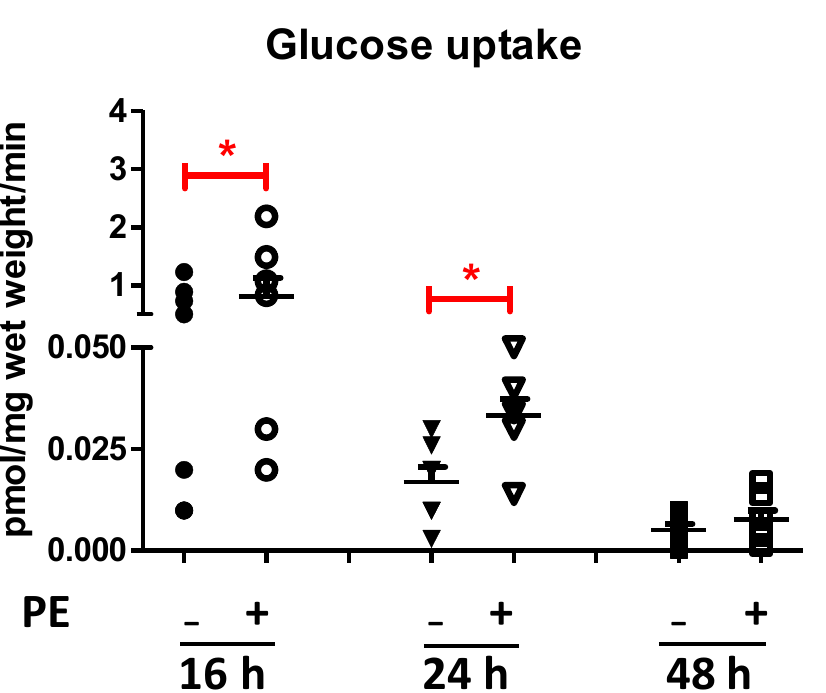
Figure 3. Time-dependent effect of phenylephrine on cellular substrate uptake. Glucose uptake after 16 h, 24 h, and 48 h phenylephrine (50 µM) stimulation, expressed in pmol/mg wet weight/min. Values are expressed as means ± STDEV for each incubation time ( n = 7). * p < 0.05 was considered significantly different compared to control at the same incubation time.